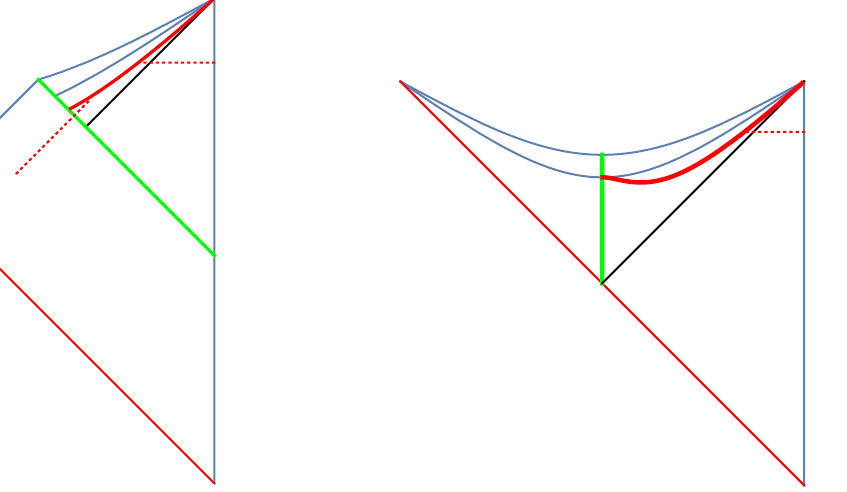
Figure 8. Scaling surface in the d = 3 Schwarzschild black brane drawn with solid red line on the Penrose diagrams. The (cid:12)rst blue line behind the horizon is z = z HM . (The second is the singularity.) Otherwise we use the same color coding as on (cid:12)gure 5. For this plot we chose (cid:26) c = 1 (for visualization purposes), but for the scaling surface to be a good approximation to the HRT surface, we have to choose a large (cid:26) c . Left: in the Vaidya setup the HRT surface sketched by red dotted line starts in the pure AdS region, crosses the null shell, then skims the scaling surface, and (cid:12)nally reaches the boundary. The extensive part of the entropy is equal to the area of the scaling surface between the points where the red dotted lines reach and depart it. Right: in the end of the world brane setup the HRT surface starts very close to the scaling surface, then shoots out to the boundary sketched with red dotted